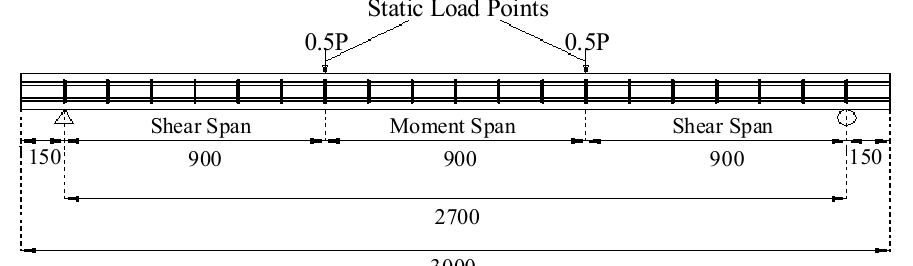
Figure 6. Experimental set-up to detect the reinforcement in one-way RC slab (adopted from Figure 12 in